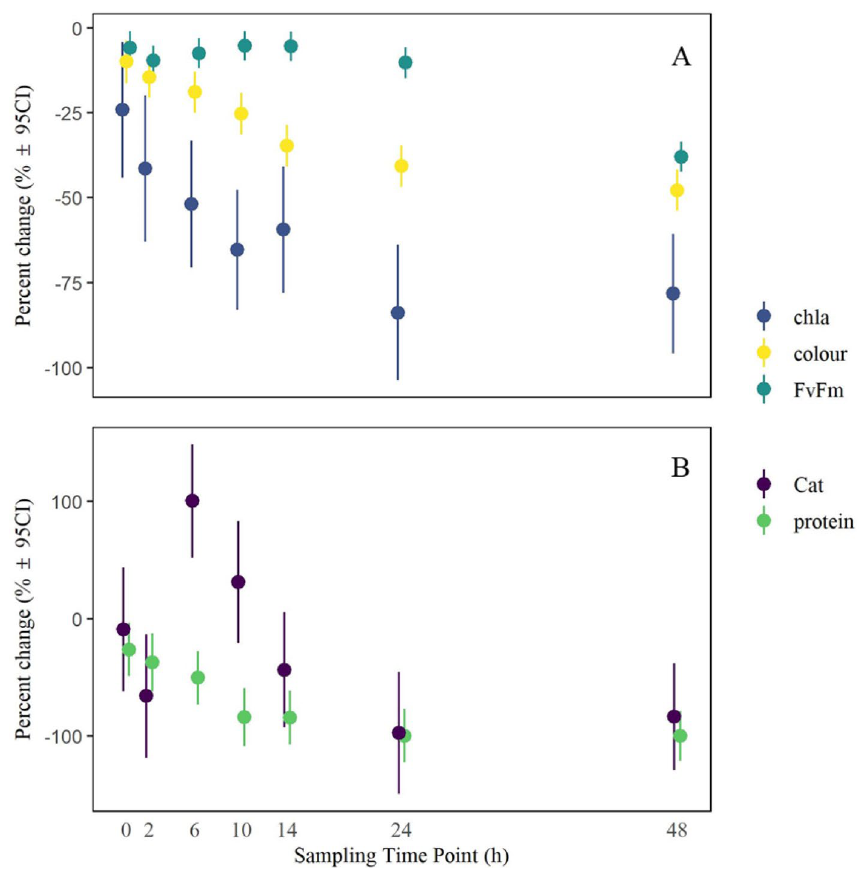
Figure 2. Percent change in physiological metrics over time in heat-treated relative to ambient corals. Fragments from nine colonies were sampled through time at 0–48 h (T 0 –T 6 ) after the end of heat stress from both an ambient (29.6 °C) and heated treatment (34.6 °C). ( A ) Fluorometric and colour assays. ( B ) Biochemical assays. Points represent the estimated marginal means of physiological metrics at each sampling time point (T 1 – T 6 ). Error bars indicate the upper and lower 95% confidence